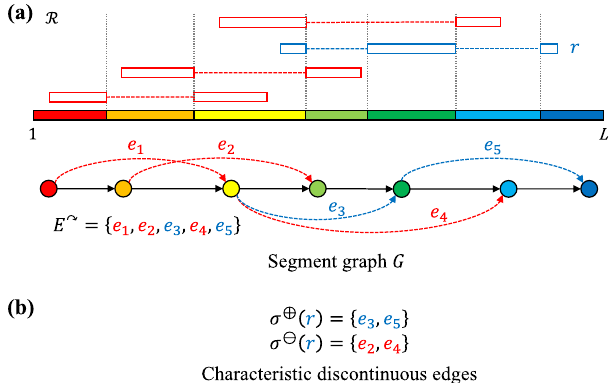
edges. a Split reads in an alignment R de fi ne a set of junctions, which in turn de fi ne the segment graph G . b Each split read has characteristic discontinuous edges indicating the set σ ⊕ of discontinuous edges present in the read as well as con fl icting/overlapping discontinuous edges σ ⊖ . Here, split read r (blue), has σ ⊕ ( r ) = { e 3 , e 5 } and σ ⊖ ( r ) = { e 2 , e 4 }. Note that e 1